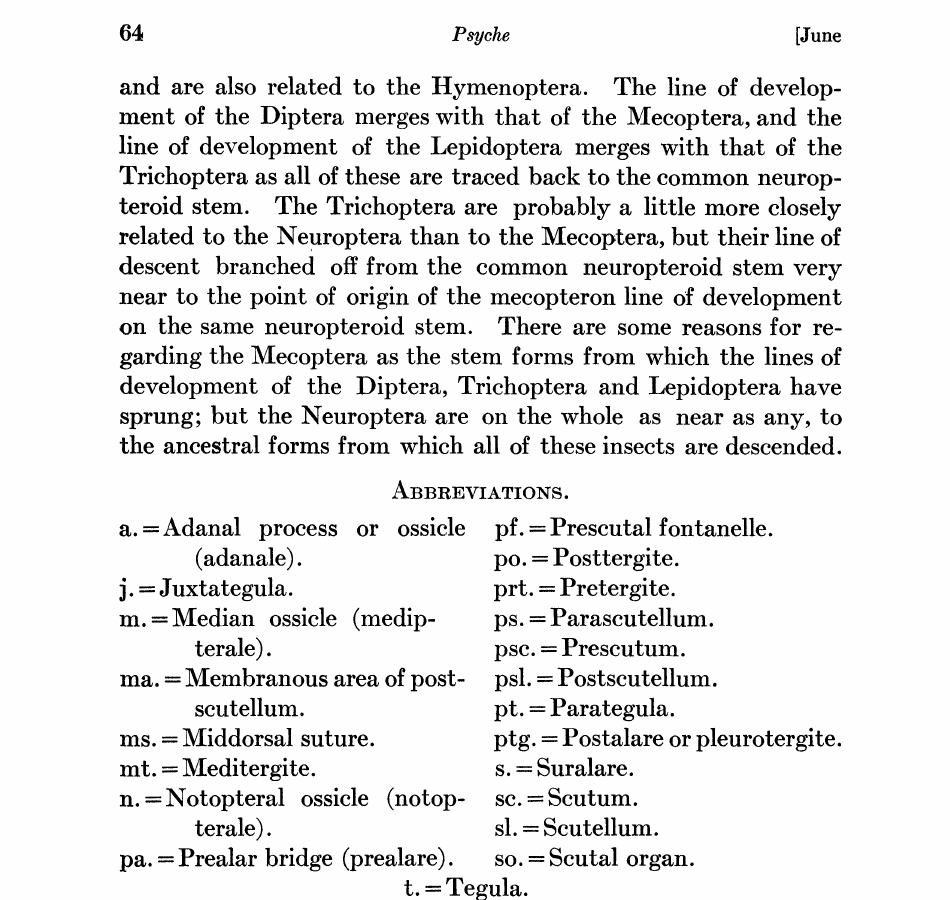
pf. Prescutal fontanelle. po. Posttergite. prt. Pretergite. ps.-- Parascutellum. psc. Prescutum. psl.= Postscutellum. pt. Parategula. ptg.= Postalare or pleurotergite. s. Suralare. sc. Scutum. sl. Scutellum. so. Scutal organ. t. Tegula. EXPLANATION OF PLATE II.